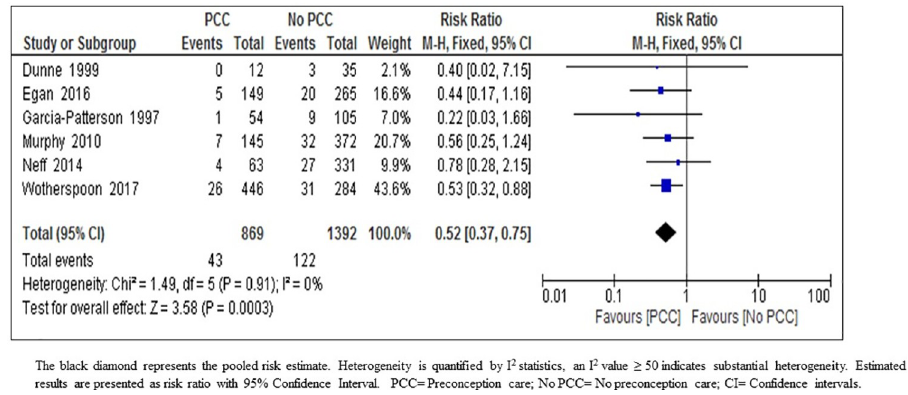
Fig 8. Risk ratio for small for gestational age from six studies of women with pre-existing diabetes mellitus who did or did not receive preconception care.